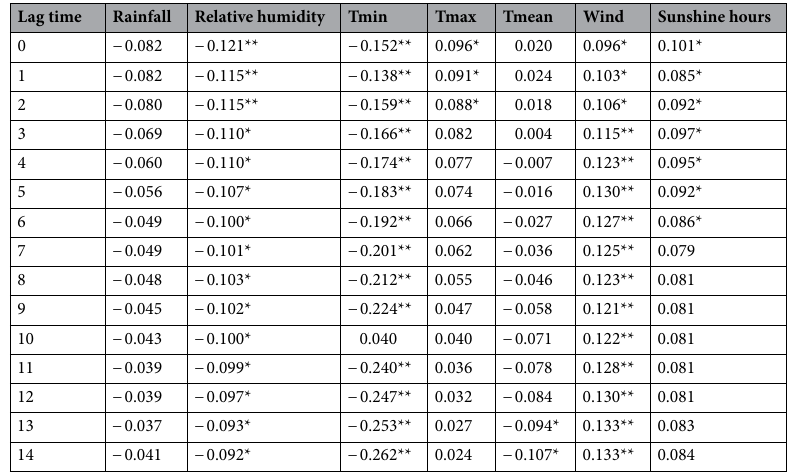
Table 2. Spearman’s rank correlation coefficient between daily confirmed positive COVID-19 cases and climate variables for Lag 0 to 14 days in Addis Ababa. Tmin, Tmax and Tmean are minimum, maximum and mean temperature, respectively. *Correlation is significant at the 0.05 level (2-tailed). **Correlation is significant at the 0.01 level